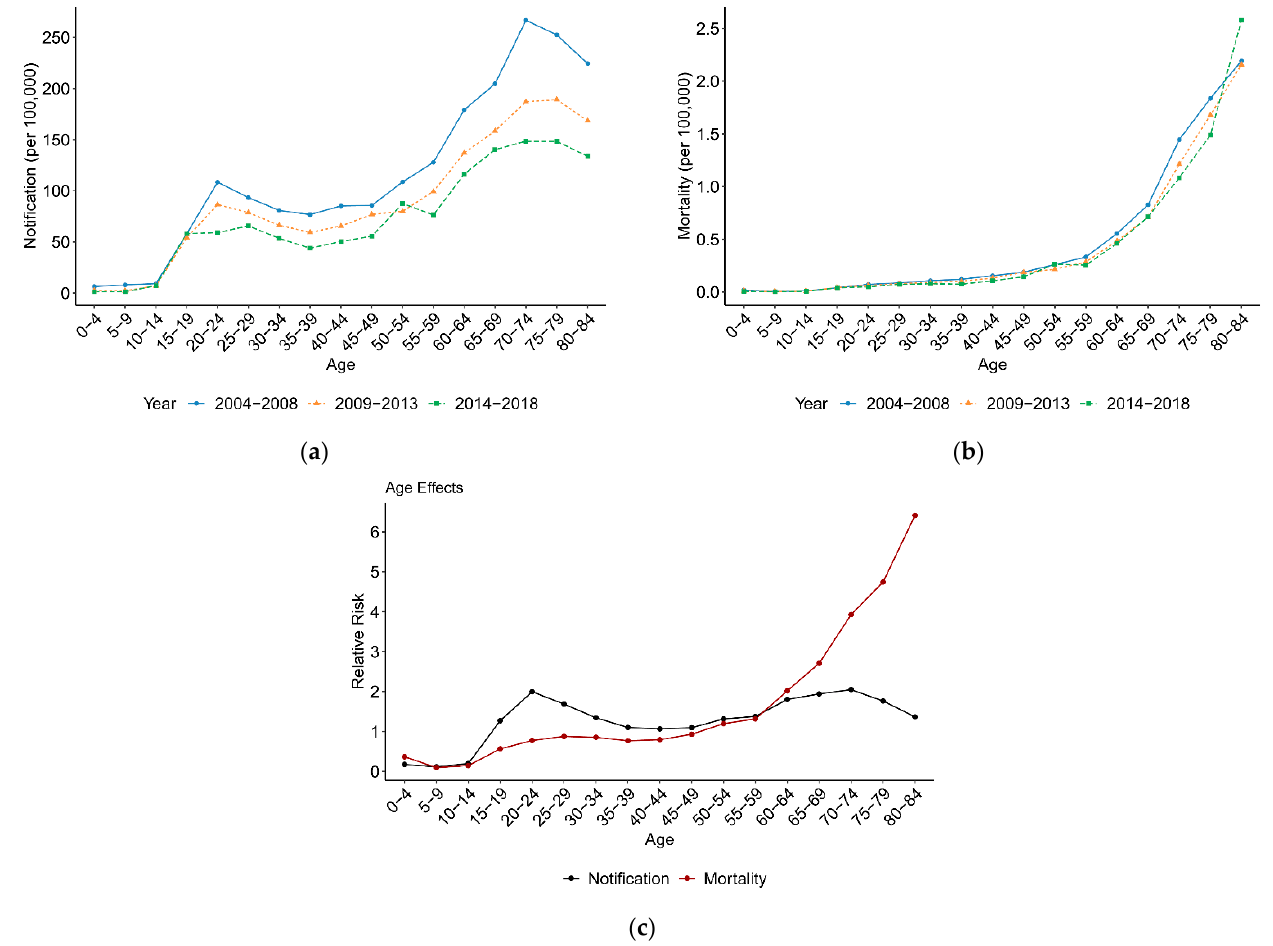
Figure 2. TB notification and mortality variation with age between 2004 and 2018, and the age effects on TB notification and mortality. ( a ) TB notification variation with age. ( b ) TB mortality variation with age. ( c ) Age effects.